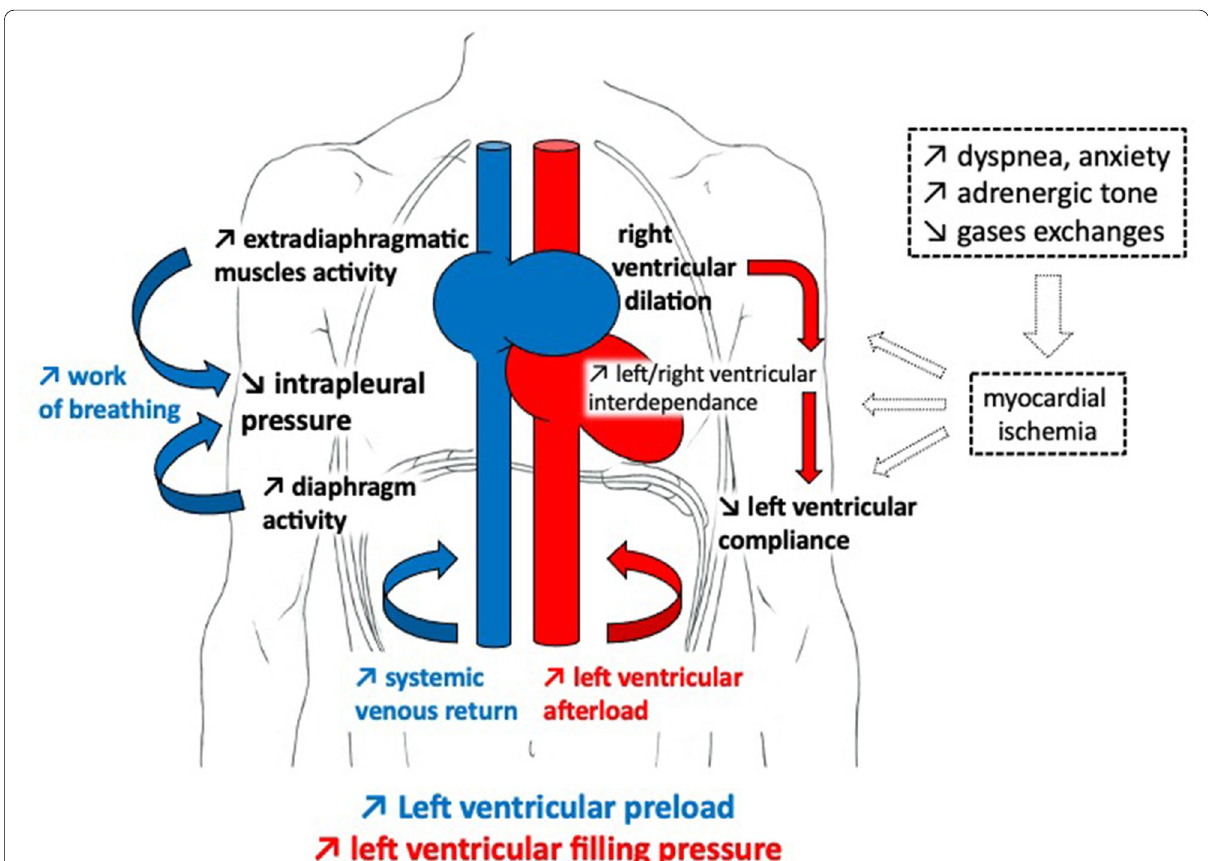
Fig. 4 Main pathophysiological mechanisms involved in the occurrence of weaning-induced pulmonary oedema. The decrease is intrathoracic pressure is mediated through the contraction of the diaphragm and extradiaphragmatic respiratory muscles. It may lead to an increase in systemic venous return and cardiac preload. The decrease in intrathoracic pressure is also responsible for an increase in left ventricular afterload. The increase in right ventricular preload could induce a right ventricular dilation that can lead to ventricles interdependence and impaired left